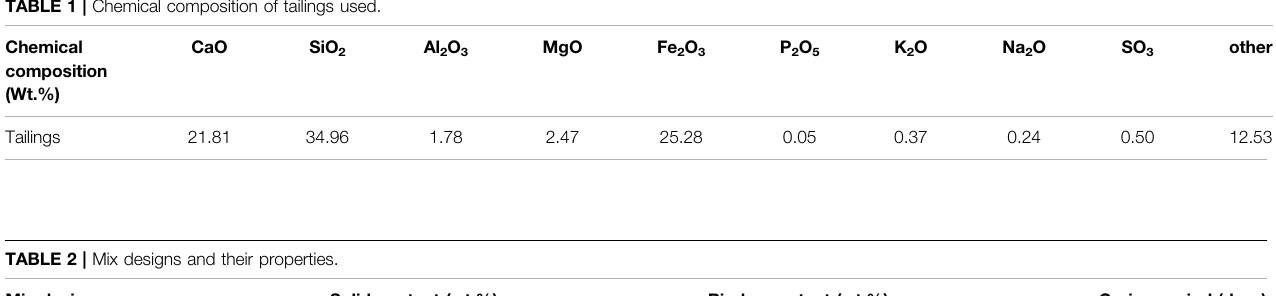
Table 2 . The following naming system was used to represent speci fi c mix designs: